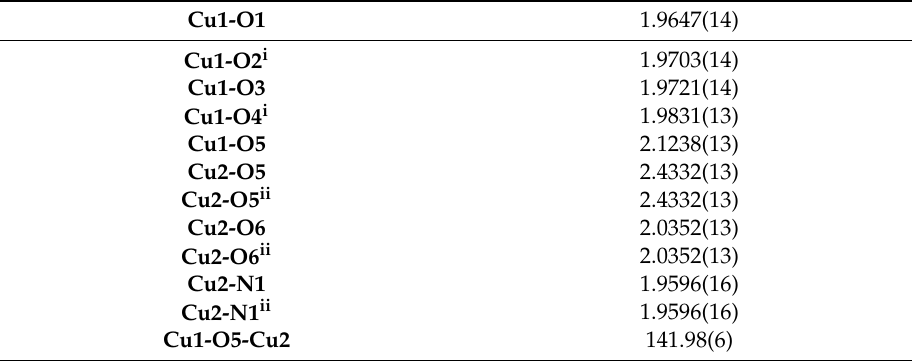
Table 1. Selected Bond Lengths (Å) and Angles ( o ).